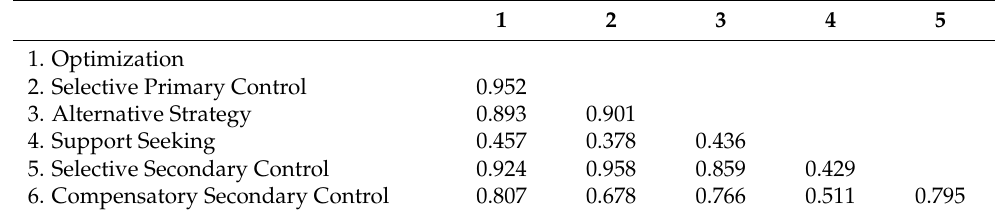
Table 3. Factor correlations.